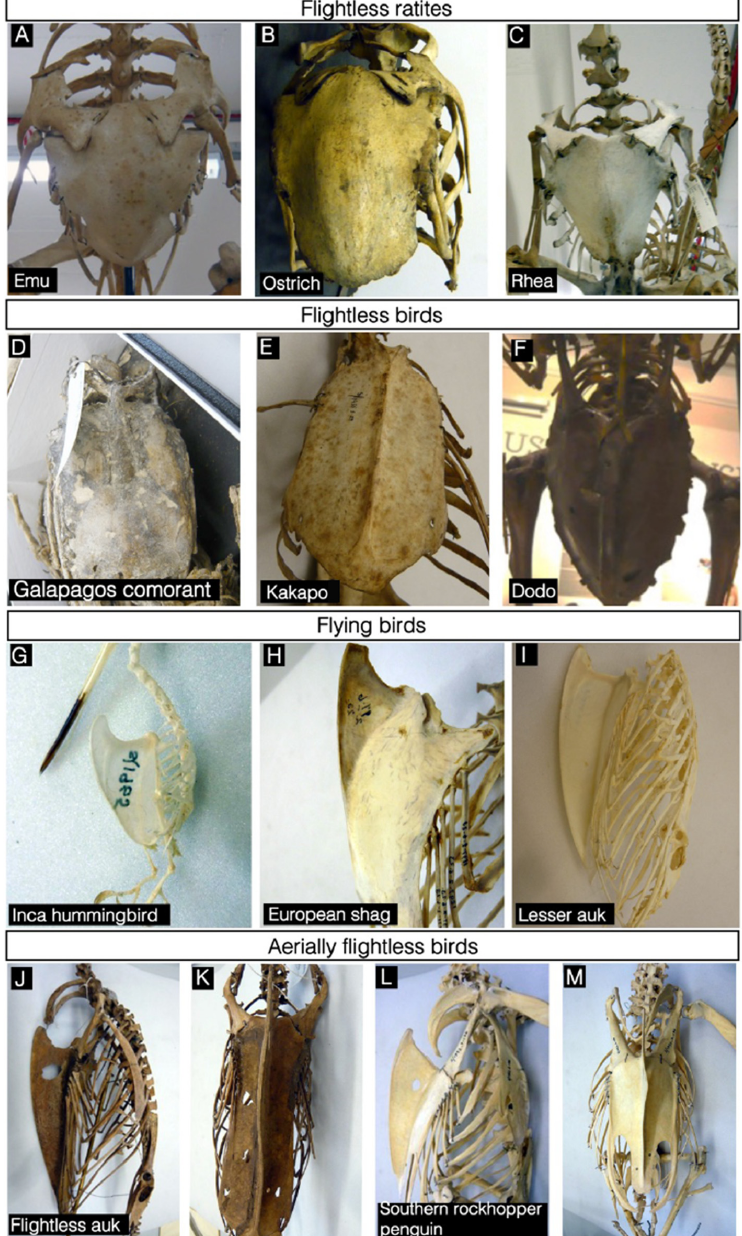
Figure 2. Sternal morphology in flightless and flying birds. Photographs of skeleton preparations of sterna in a diverse range of birds, orientated anteriorly (( A – F ), ( K ) and ( M )) or laterally (( G – I ), ( J ) and ( L )). In flightless ratites and birds such as the emu, ostrich, rhea and galapagos comorant the sternum is flat with the absence of a ventral sternal keel extension ( A – D ). The flightless kakapo and Dodo have a reduced sternal keel ( E , F ). In flying birds, including the Inca hummingbird, European Shag and Lesser auk the sternal keel is greatly extended ventrally ( G – I ). The aerially flightless southern rockhopper penguin ( J , K ) and flightless auk ( L , M ) have an extended sternal keel, when viewed ventrally the keel is curved ( K , M ).